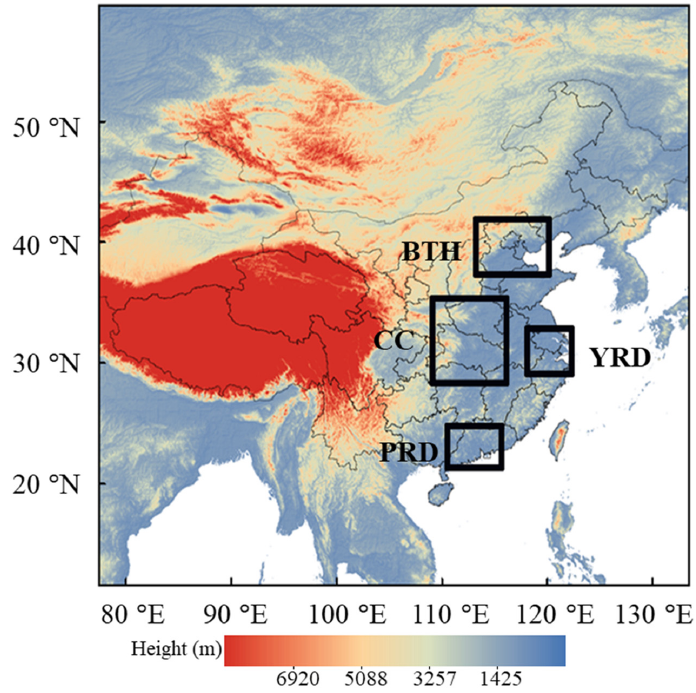
Figure 1. The four study regions in China including the BTH, the CC, the YRD, and the PRD. The shadow represents the height of the terrain (m).